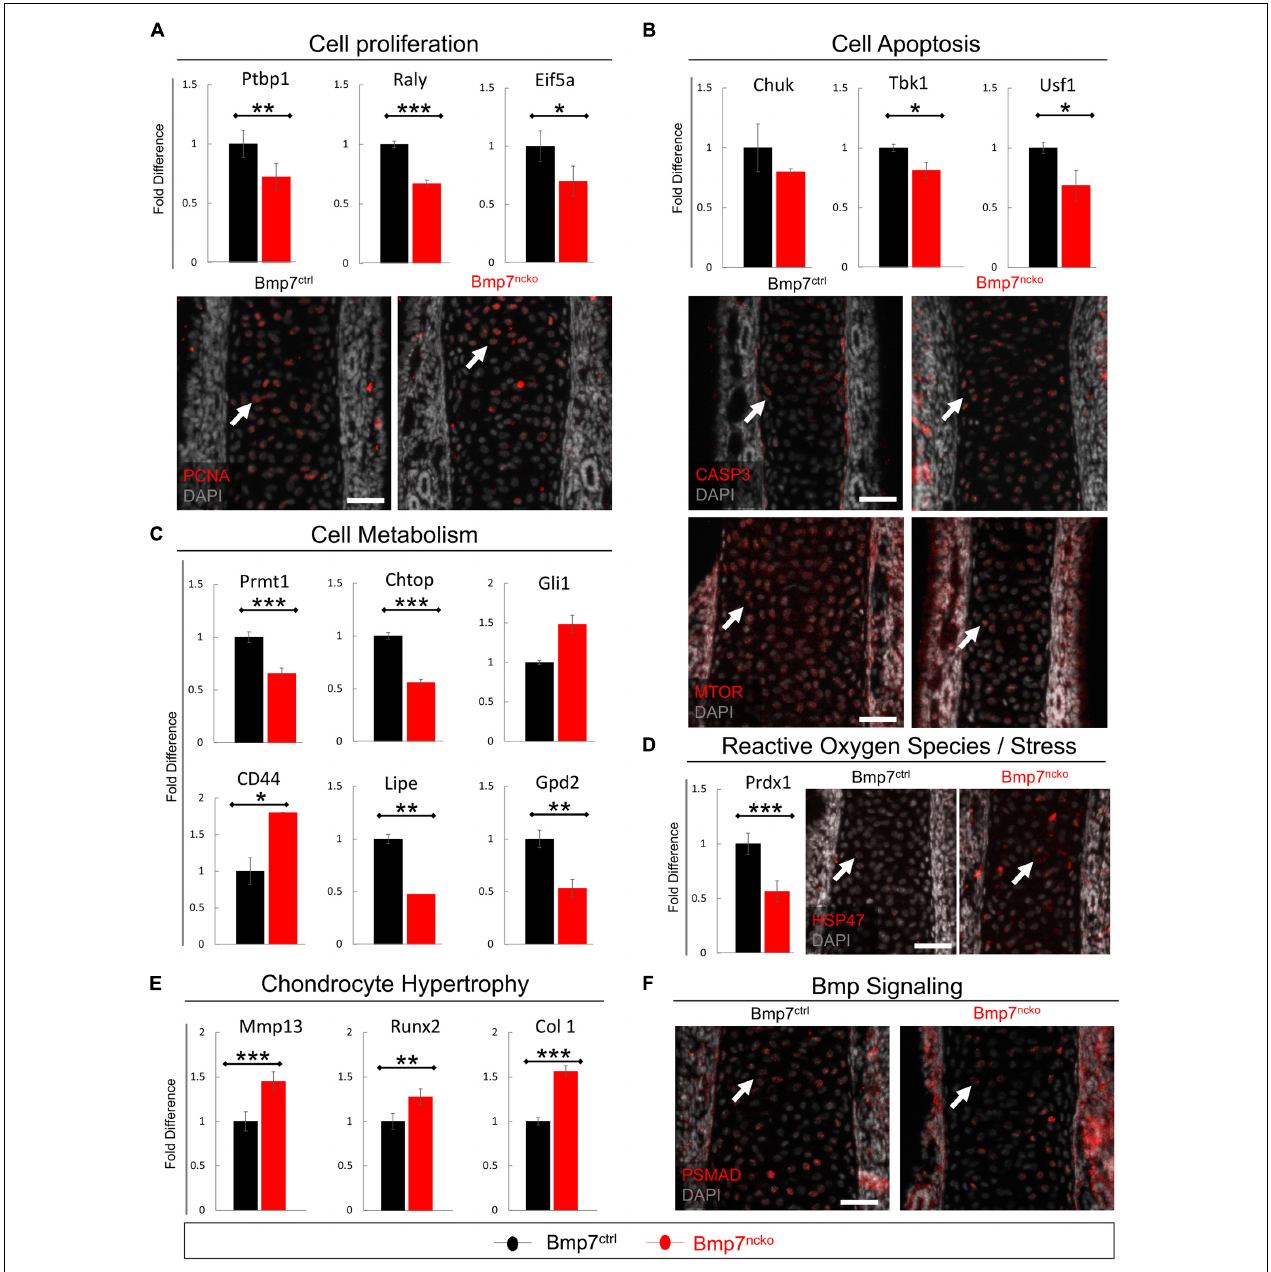
FIGURE 7 | Altered cell proliferation, apoptosis and Bmp signaling precede nasal septum deviation. qRT-PCR validation on P0 dissected nasal septum of genes identified in RNASeq analysis and immunofluorescence staining revealed alteration to (A) cell proliferation as evident by reduced PTBP1, RALY, and EIF5a as well as PCNA expression in Bmp7 ncko mice. (B) Increased cell apoptosis was observed as demonstrated by reduced expression of CHUK, TBK1, USF1, increased CASP3 expression and reduced mTOR expression. (C) Alterations to lipid metabolism were observed by a significant reduction in PRMT1, CHTOP, LIPE, and GPD2 with an increase in CD44 expression. (D) A reduction in expression of PRDX1 and an increase in expression of stress protein HSP47 was observed. (E) An increase in MMP13, RUNX2, and COL 1 was observed in Bmp7 ncko mice. (F) Bmp signaling assessed using immunofluorescence staining of PSMAD revealed a decrease in pSMAD in P0 Bmp7 ncko mice. PTBP1, Polypyrimidine tract-binding protein 1; RALY, Heterogeneous Nuclear Ribonucleoprotein; EIF5A, Eukaryotic Translation Initiation Factor 5A; CHUK, Component Of Inhibitor Of Nuclear Factor Kappa B Kinase Complex; TBK1, TANK Binding Kinase 1; USF1, Upstream Transcription Factor 1; PRMT1, Protein Arginine Methyltransferase 1; CHTOP, Chromatin Target Of PRMT1; GLI1, GLI Family Zinc Finger 1; LIPE, Lipase E; GPD2, Glycerol-3-Phosphate Dehydrogenase 2; PRDX1, Peroxiredoxin 1; MMP13, matrix metalloproteinase 13; RUNX2, RUNX Family Transcription Factor 2; COL 1, Collagen I; PCNA, Proliferating Cell Nuclear Antigen; CASP3, Cleaved Caspase 3; MTOR, Mammalian Target of Rapamycin; HSP47, SERPINH1; pSMAD, Phosphorylated Smad. Independent two-tailed t -test was performed with significance denoted as *: p < 0.05, **: p < 0.01, ***: p < 0.001. ( n = 3/genotype/age). Antibody expression demonstrated in red and DAPI stained nuclei in gray for all immunofluorescence images. Arrows denoting positive antibody signal. Scale bar = 50 µ m.